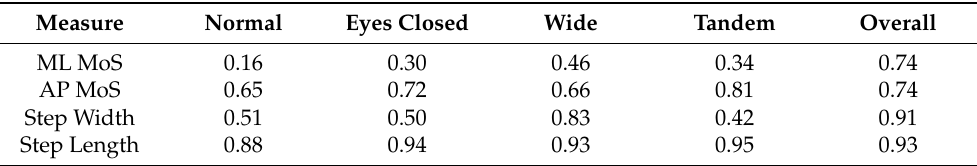
Table 2. ICC values to assess reliability of inertial measurement units (IMU) compared to optical motion capture (Optical). ‘Overall’ combines data from all conditions.